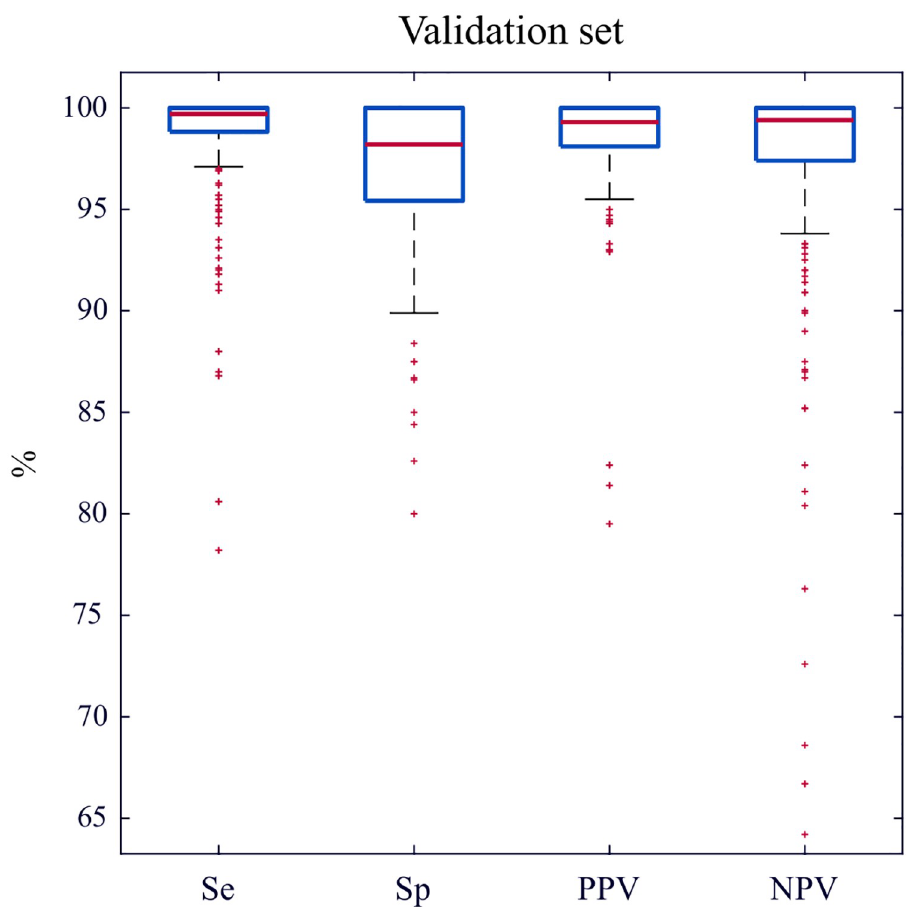
Fig 3. Algorithm performance metrics. Distributions per episode in the validation